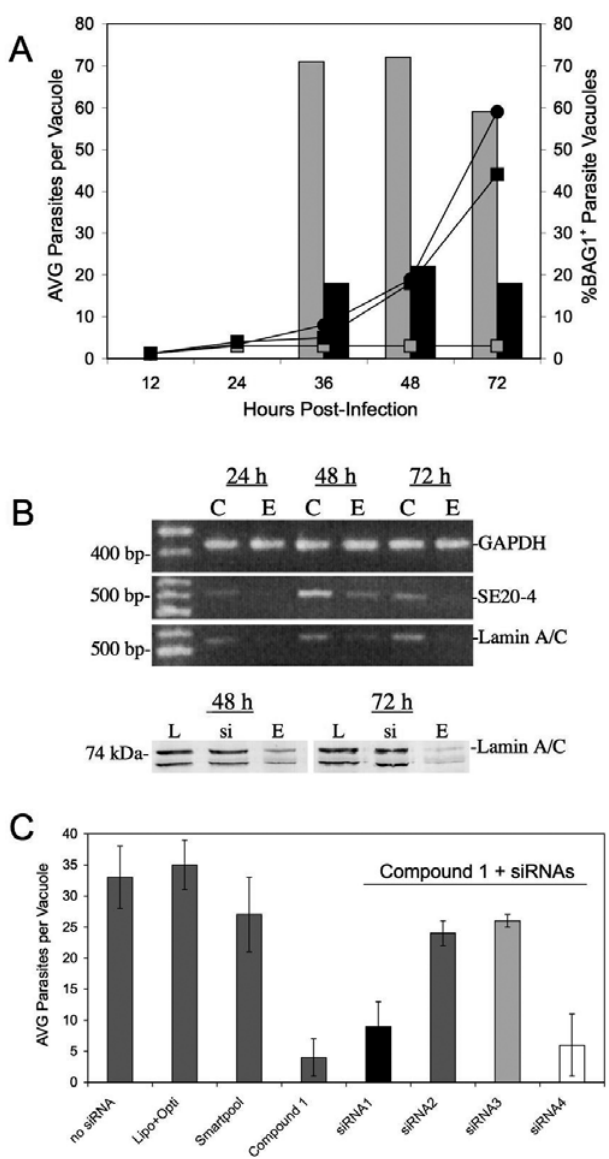
Figure 3. siRNAs against CDA1 Antagonize Compound 1 Inhibition of Parasite Growth (A) HFF cells transfected with the siRNA SmartPool against CDA1 and co- treated with Compound 1 prior to parasite infection allow normal parasite growth (black boxes) and BAG1 expression (dark bars). Compare growth in untreated controls (black circles) with growth (grey boxes) and BAG1 expression (light bars) in Compound 1–treated cells. (B) Concurrent with the restoration of normal parasite growth and BAG1 expression, we observed the loss of Compound 1–induced CDA1 mRNAs as measured by RT-PCR of total RNA at 24, 48 following transfection with siRNA and Compound 1 pretreatment. Lamin A/C controls demonstrate siRNA-mediated knockdown of individual genes. Transfection with siRNAs against Lamin A/C, with nonspecific siRNAs or with Lipofect- AMINE alone, was unable to antagonize Compound 1 inhibition of parasite growth or induction of BAG1 expression (results not shown). RT- PCR primers specific to GAPDH were used as a control for RNA quality. RT-PCR experiment: C ¼ Compound 1 pretreatment (3 h/3 l M) only; E ¼ HFF cells pretreated with both Compound 1 and siRNA(s) against either CDA1 or Lamin A/C. Protein blot: L ¼ HFF cells pretreated with LipofectAMINE, but without siRNAs; si ¼ HFF cells pretreated with siRNAs against either CDA1 or Lamin A/C, but without transfection reagent (LipofectAMINE); E ¼ same as above. (C) Co-transfection of HFF cells with siRNAs 1 to 4 separately and then treatment with Compound 1 prior to parasite infection demonstrate